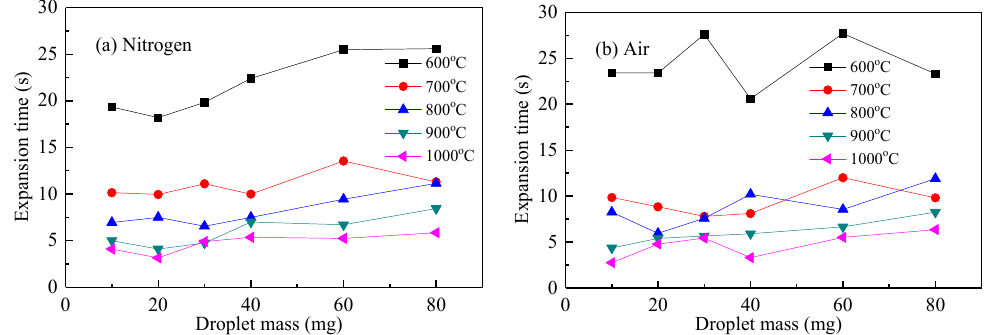
Figure 9. Swelling time curve of waste liquor droplet. ( a ) expansion time with droplet mass in N 2 ; ( b ) expansion time with droplet mass in air.